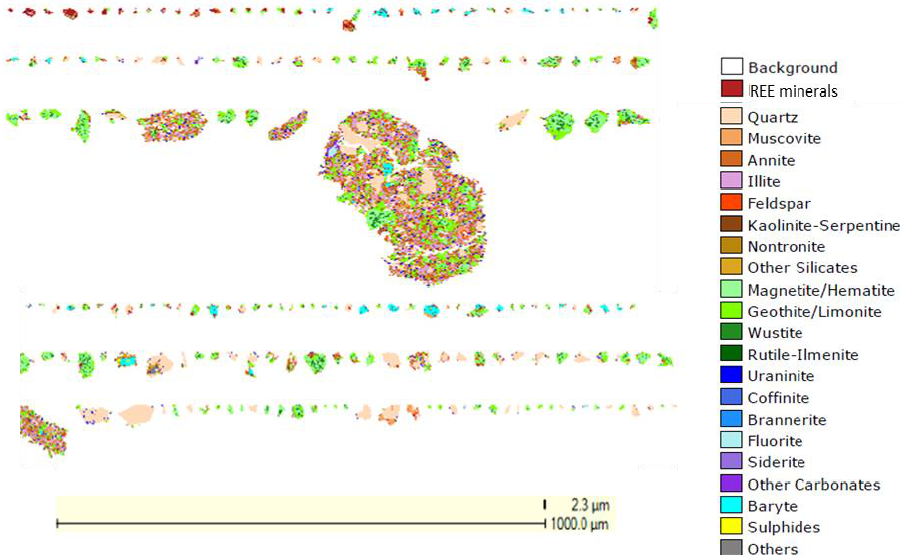
Figure 3. Particle view of flotation concentrate from Flowsheet A in Figure 1.